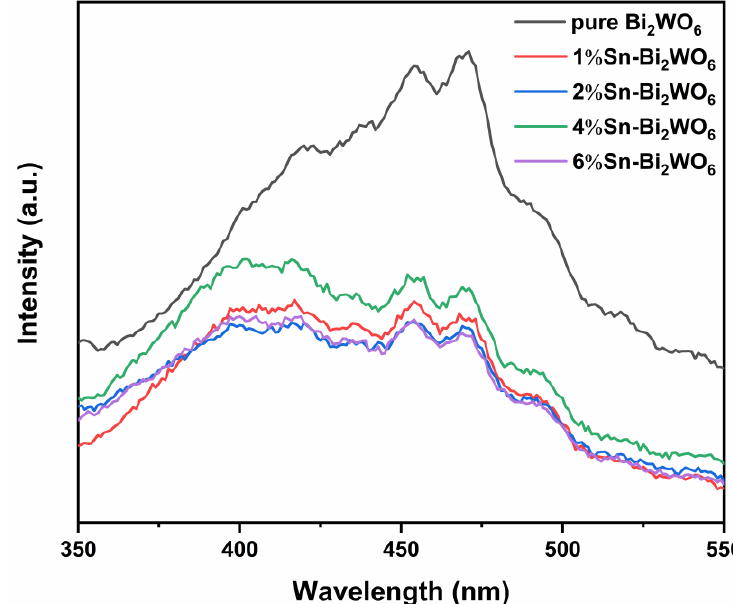
Figure 6. PL spectra of samples.